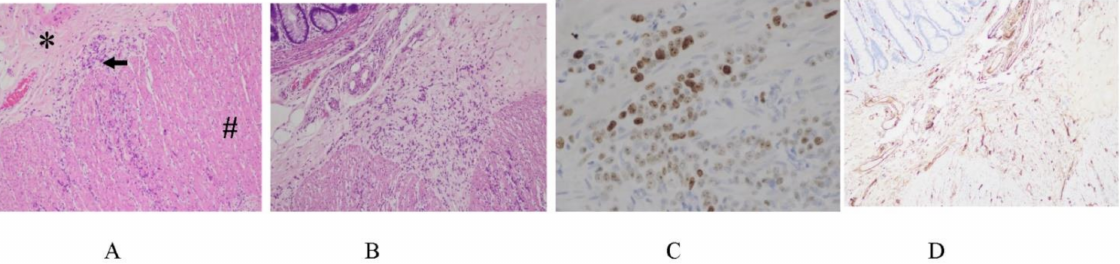
Figure 18. ( A ) Micrometastasis of poorly differentiated adenocarcinoma (arrow) growing on the subserosal layer of the rectum in Douglas pouch (*) and muscle layer of the rectum (#) (HE stain- ing). Stromal induction is already found. ( B ) Poorly differentiated adenocarcinoma invading the submucosal layer. ( C ) Ki67-positive cancer cells in the submucosal layer. ( D ) Interstitial tissue of micrometastasis in the submucosal layer shows CD34